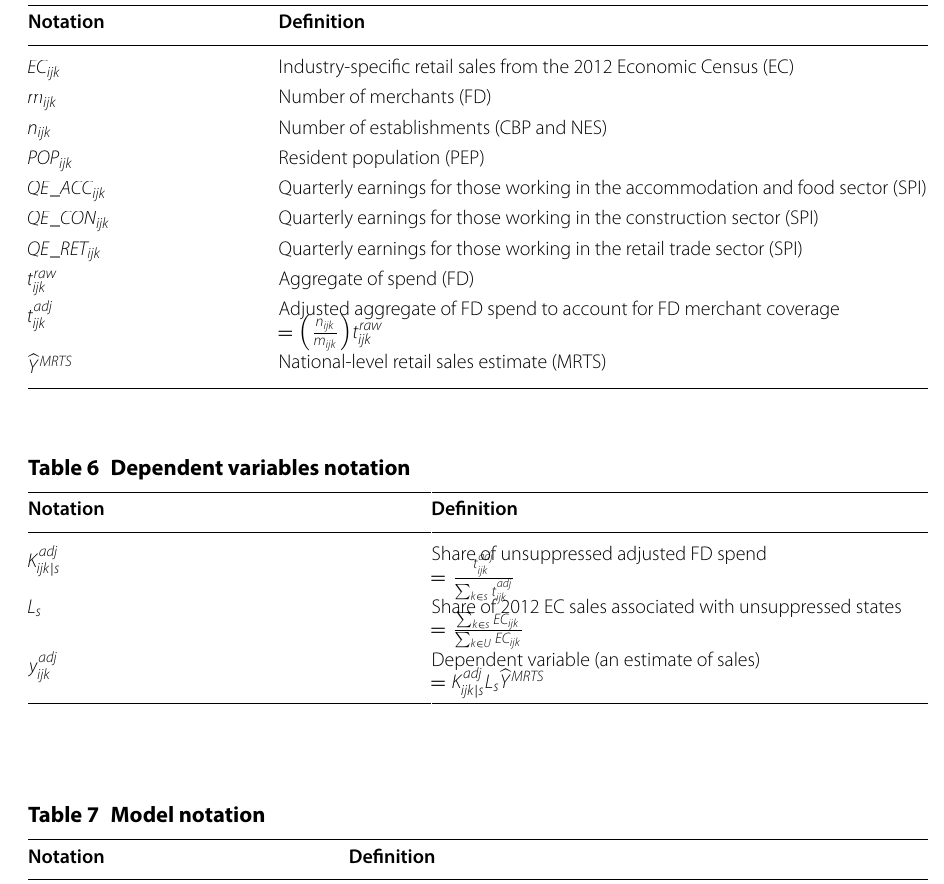
Table 5 Basic input notation